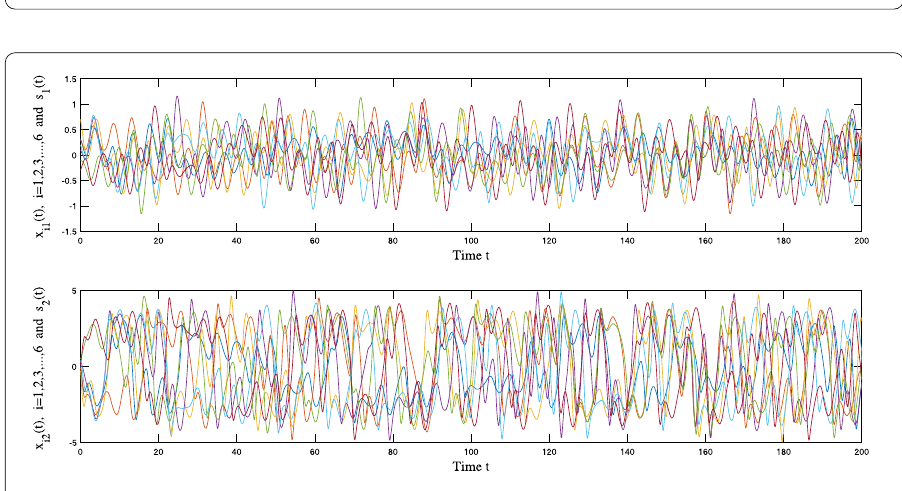
Figure 10 The trajectory of the isolated node (43) and network (1) with the time-varying scaling function